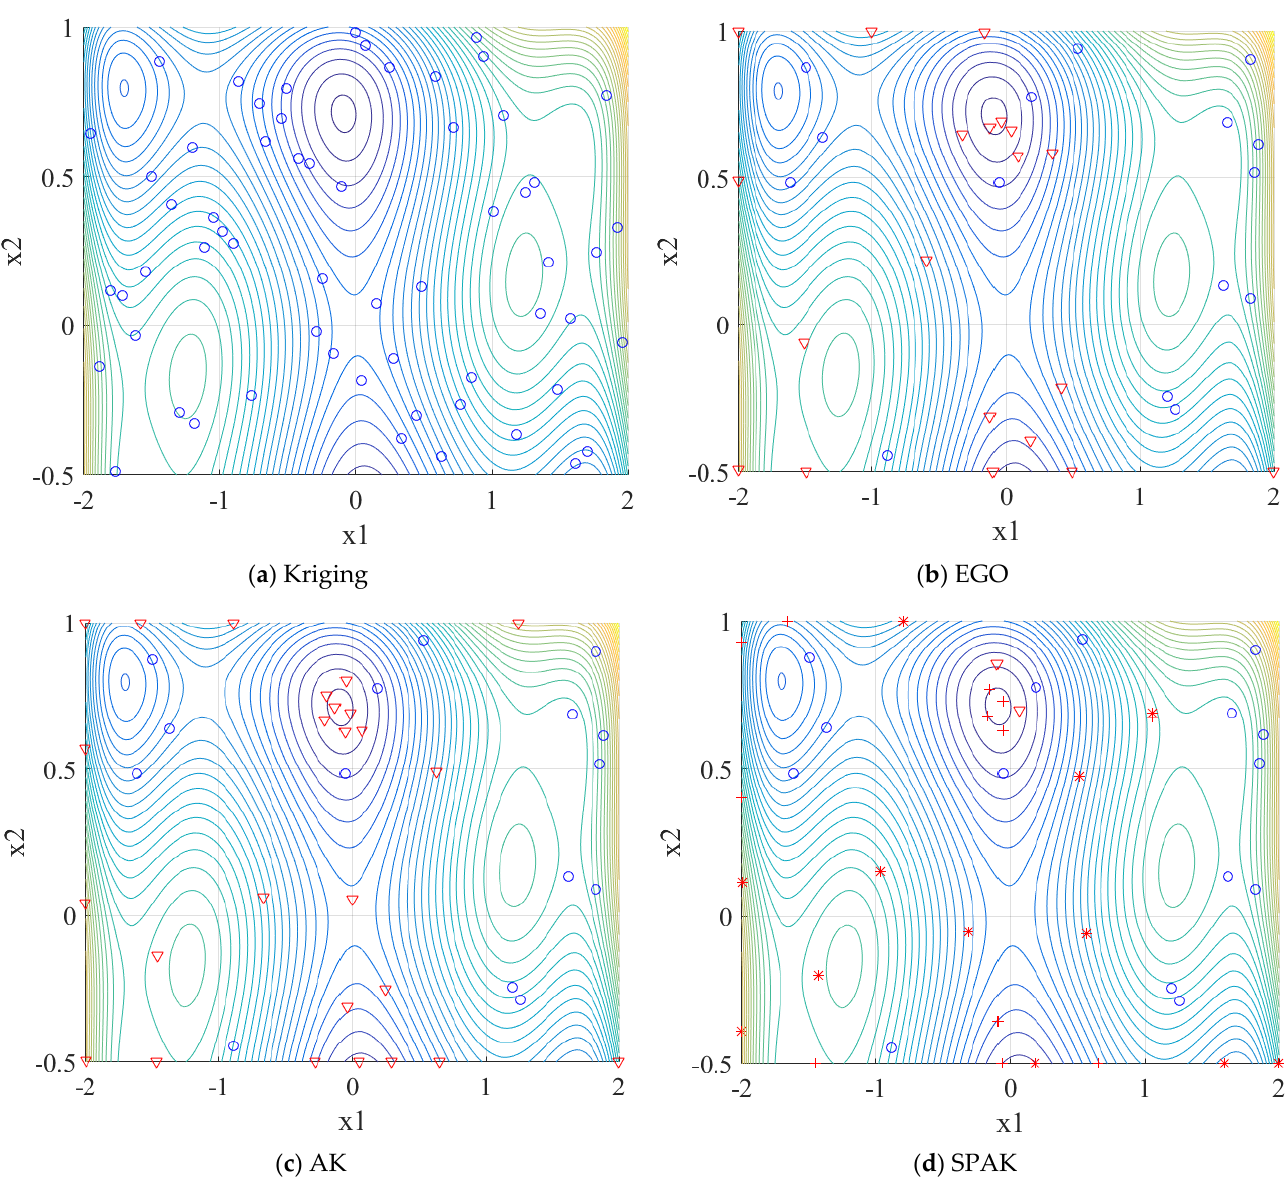
Figure 6. Training process of once for Example 2 ( О : initial points, ▽ : Sequential training points, * and + are parallel training points).